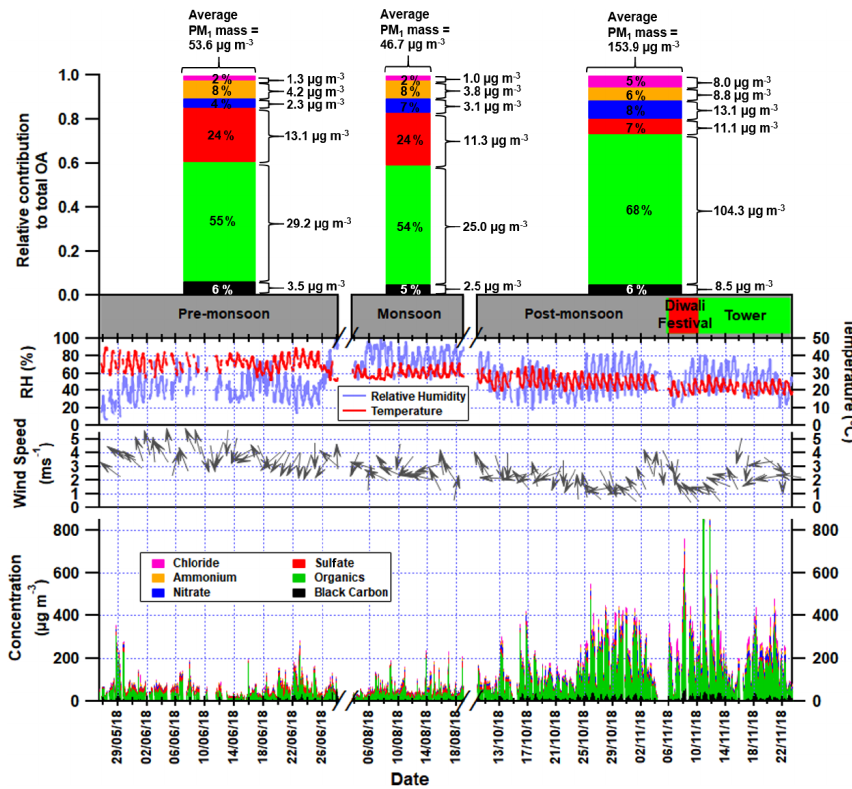
Figure 1. First panel: average relative contributions of chloride, ammonium, nitrate, sulfate, organic aerosol and black carbon to the total PM 1 mass loadings in the pre-monsoon, monsoon and post-monsoon periods; the average concentrations of each species are shown to the right of each bar (see Table S5 for values and statistics). Second panel: Gantt chart showing the measurement periods, where the red region shows the Diwali festival and the green region shows when the inlet was moved to a 30m tower. Third panel: time series of the relative humidity and the temperature for the three measurement periods. Fourth panel: time series of the wind speed with arrows showing wind direction. Fifth panel: time series of stacked concentrations of aerosol species showing total PM 1